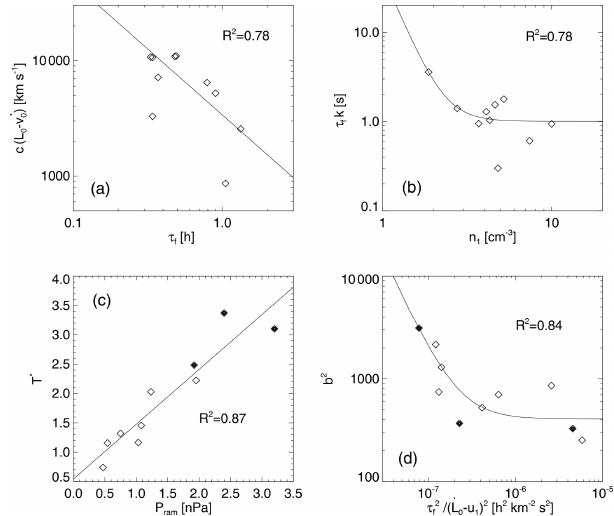
Figure 9. Empirical relations of free parameters and inputs. Open diamonds point out the data dispersion, the solid lines are the calcu- lated regression tendencies, and we also present the squared corre- lation index between the data dispersion and the associated regres-